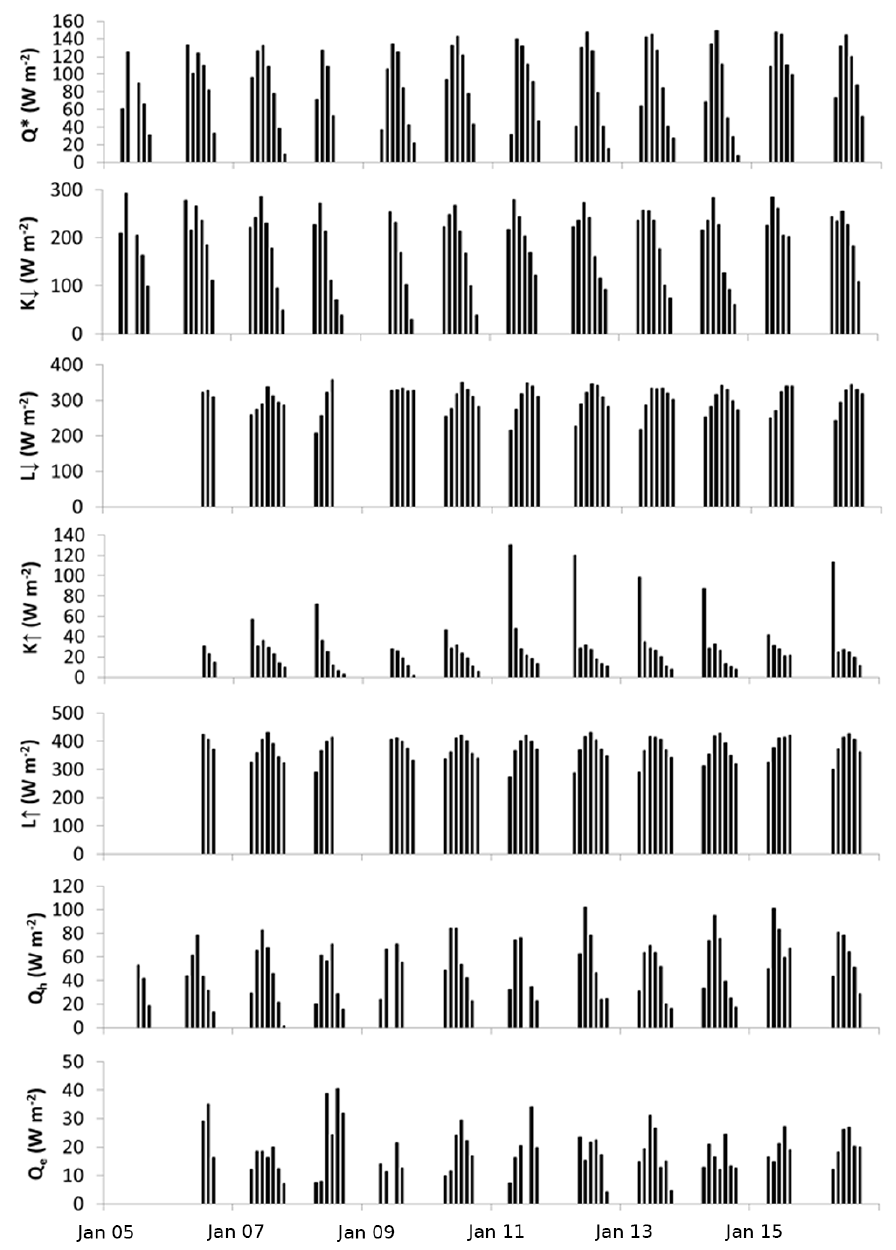
Figure 5. Monthly average radiation and energy fluxes at the bedrock ridge climate tower in 2005–2016. The radiation terms Q ∗ , K ↓ , K ↑ , L ↓ and L ↑ are net radiation, downwelling short-wave radiation, upwelling short-wave radiation, downwelling long-wave radiation and upwelling long-wave radiation, respectively. The turbulent energy fluxes are sensible heat, Q h , and latent heat, Q e .